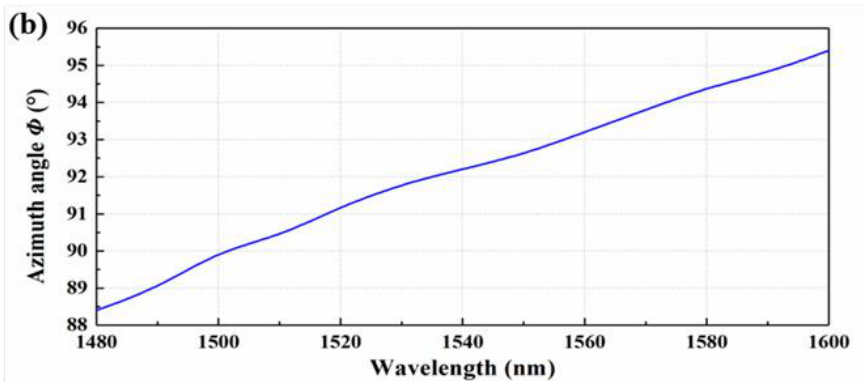
Figure 12. Azimuth scanning angle range analysis. ( a )The far-field spot distribution of the OPA. ( b ) The range of the antenna azimuth scanning angles ( Φ ).